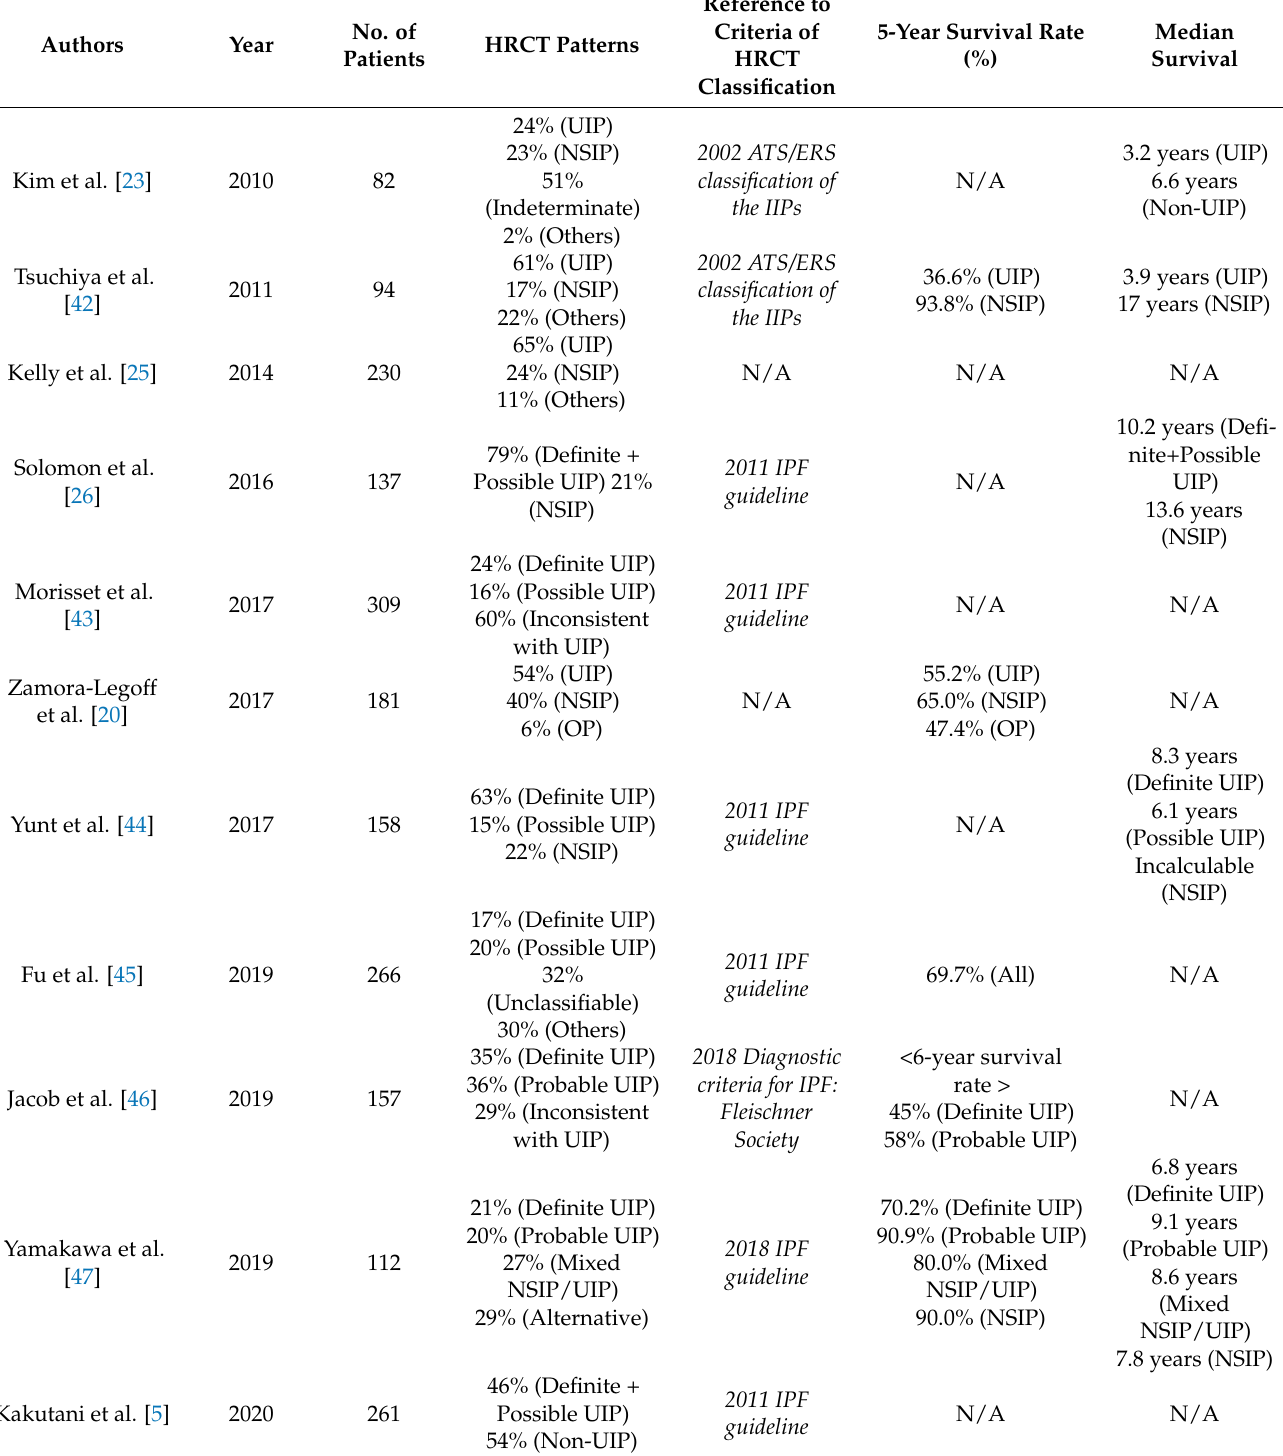
Abbreviations: ATS = American Thoracic Society; ERS = European Respiratory Society; HRCT = high-resolution computed tomography; IPF = idiopathic pulmonary fibrosis; NSIP = nonspecific interstitial pneumonia; OP = organizing pneumonia; RA-ILD = rheumatoid arthritis-associated interstitial lung disease; UIP = usual interstitial